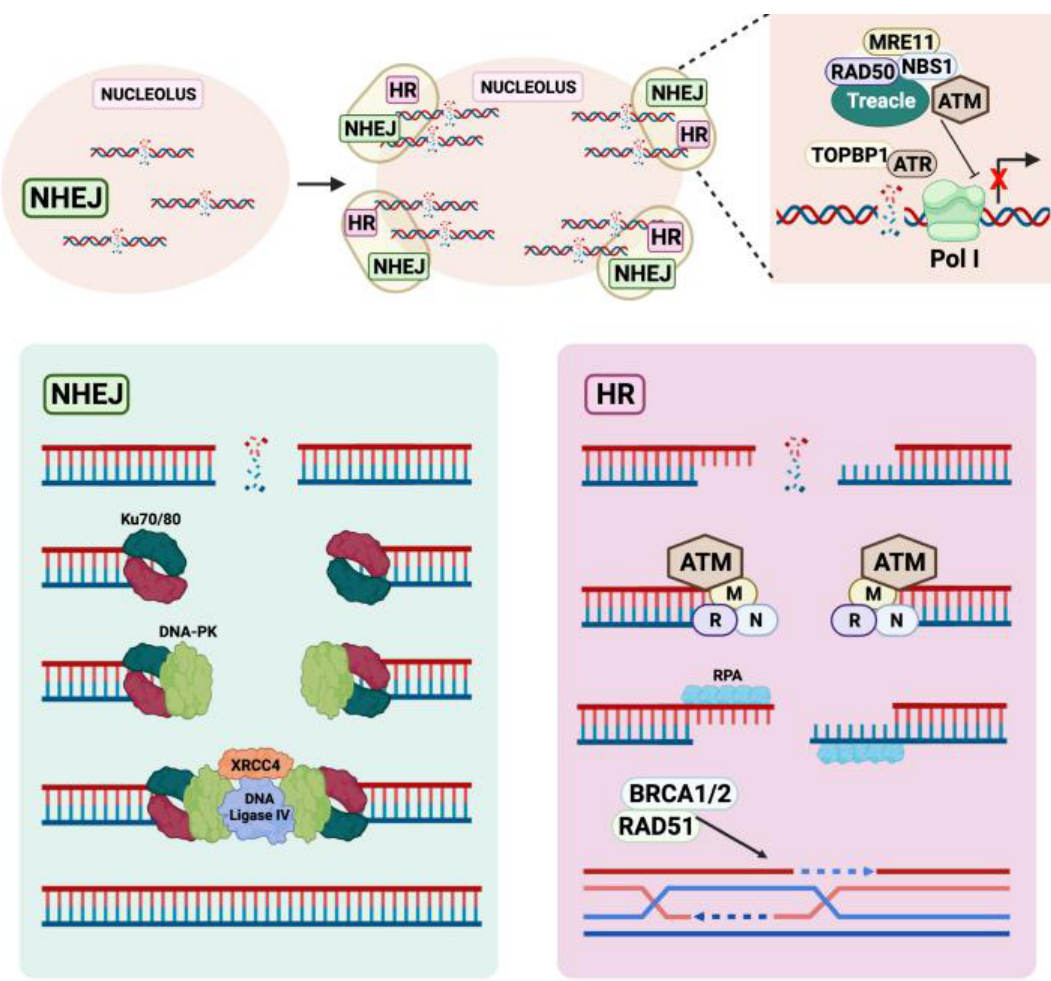
Figure 3. Mechanism of rDNA repair in the nucleolus. Low levels of rDNA damage are typically repaired via the highly mutagenic NHEJ process. It involves direct ligation of broken ends, mediated by several factors including Ku70/80 heterodimer, DNA-PK, DNA ligase IV and XRCC4 complex. Persistent rDNA damage results in ATM-mediated response that involves Treacle, the MRN complex, TOPBP1 and ATR. This leads to Pol I transcription inhibition and translocation to nucleolar caps, where HR repair occurs. HR proteins RPA, RAD51, RAD52, BRCA1 and BRCA2 are present in abundance in the nucleolar caps. Abbreviations: non-homologous end-joining (NHEJ), DNA-dependent protein kinase catalytic subunit (DNA-PK), X-ray repair cross-complementing protein 4 (XRCC4), homologous recombination (HR), ataxia telangiectasia mutated (ATM), ataxia telangiectasia and Rad3-related (ATR), DNA topoisomerase II binding protein 1 (TOPBP1), RNA Polymerase I (Pol I), replication protein A (RPA), breast cancer susceptibility protein 1 and 2 (BRCA1/2).